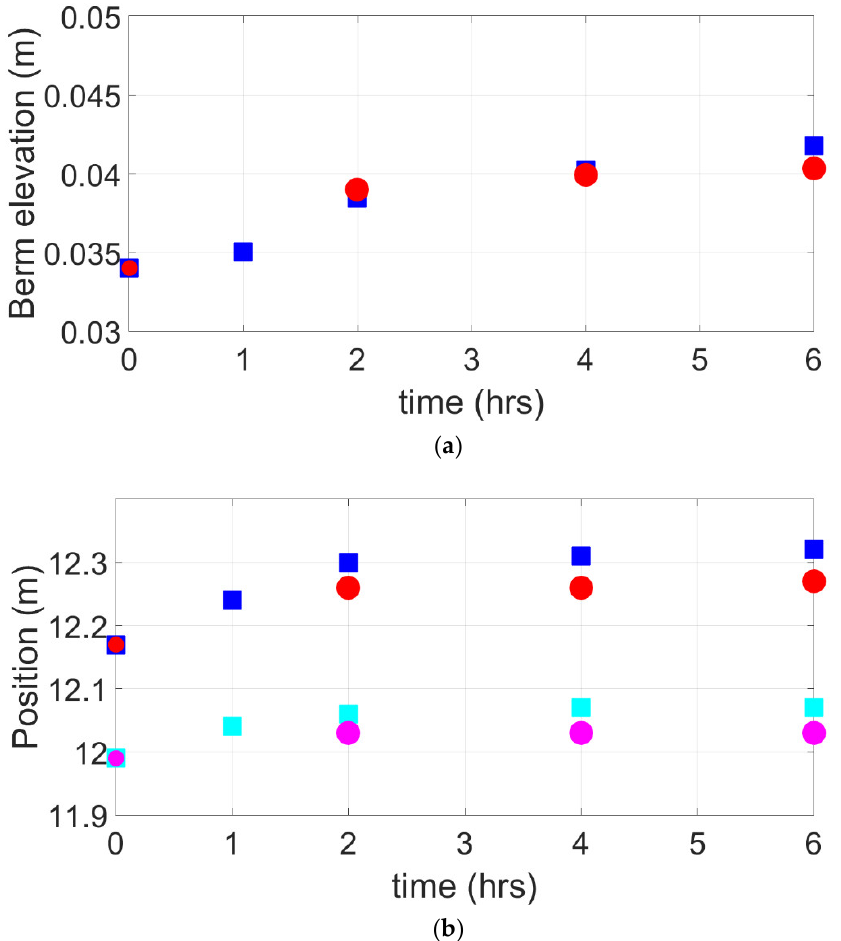
Figure 14. ( a ). Comparison between the modelled (red dots) and observed (blue squares) berm crest elevations. ( b ). Comparison between the modelled (dots) and observed (squares) shoreline (magenta vs. cyan) and berm crest positions (red vs. blue) positions.